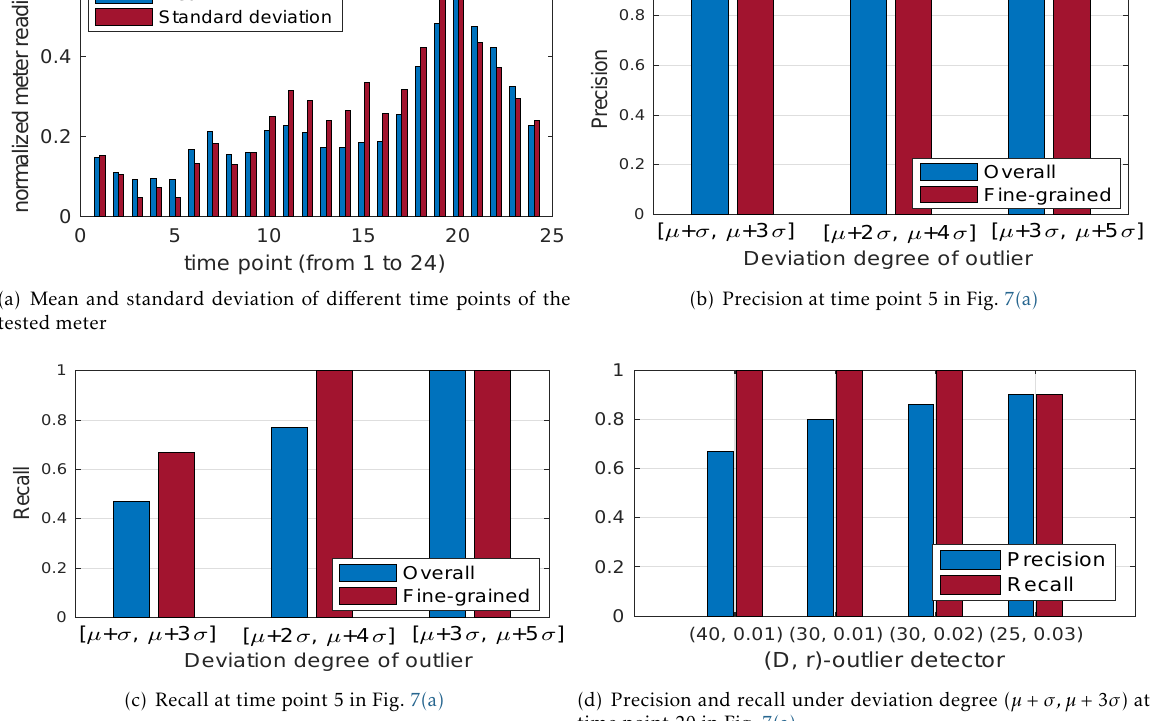
Figure 7. The comparison of overall detector and fine-grained detector for a specific meter. Fig 7(b) and 7(c) compares the performance of (40, 0.01)-outlier detector under different deviation degrees of outliers, where mean and standard deviation are set to the values at time point 5 in Fig 7(a). Fig 7(d) compares performance of different (D, r)-outlier detector under the fixed deviation degree [ µ + σ, µ + 3 σ ] at time point 20 in Fig